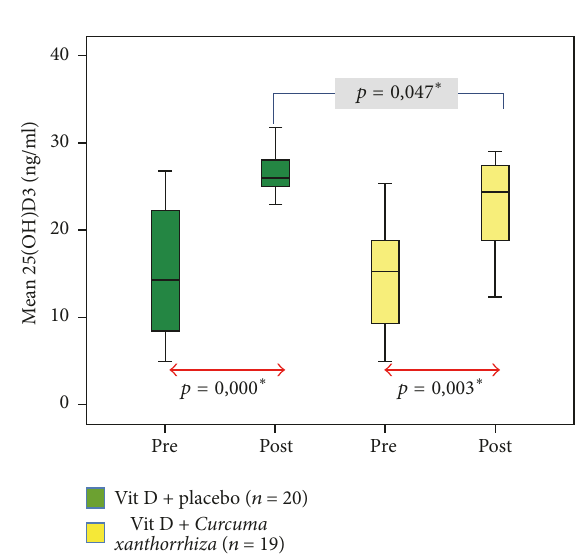
Figure 1: Effects of Curcuma xanthorrhiza supplementation on vitamin D 3 administration towards vitamin D level. ∗ There is a significant difference ( 𝑝 < 0.005